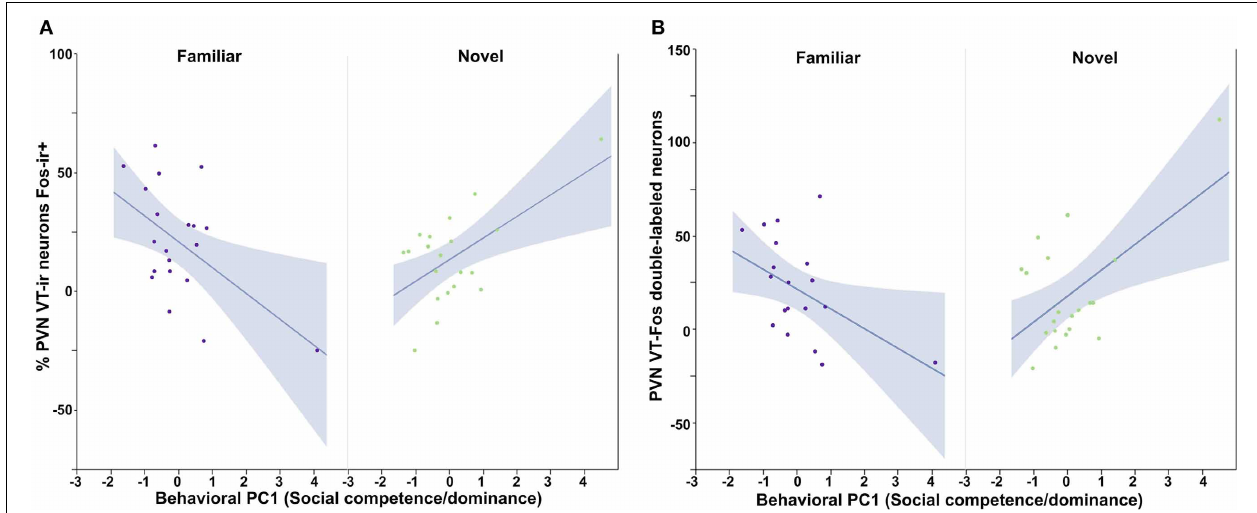
FIGURE 4 | Measures of VT-Fos co-expression in the PVN as a function of Sex and interactions between Sex and Behavioral PC1 (Social competence/dominance). (A) Social competence/dominance tends to correlate positively with PVN VT-Fos colocalization in subjects exposed to novel same-sex conspecifics, but negatively in subjects